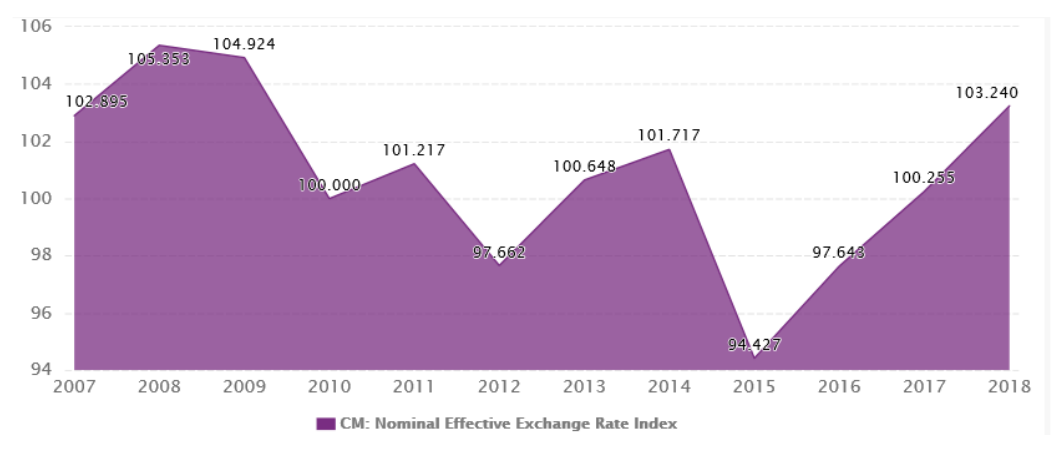
Figure 2: Nominal and real exchange rate index in Cameroon From